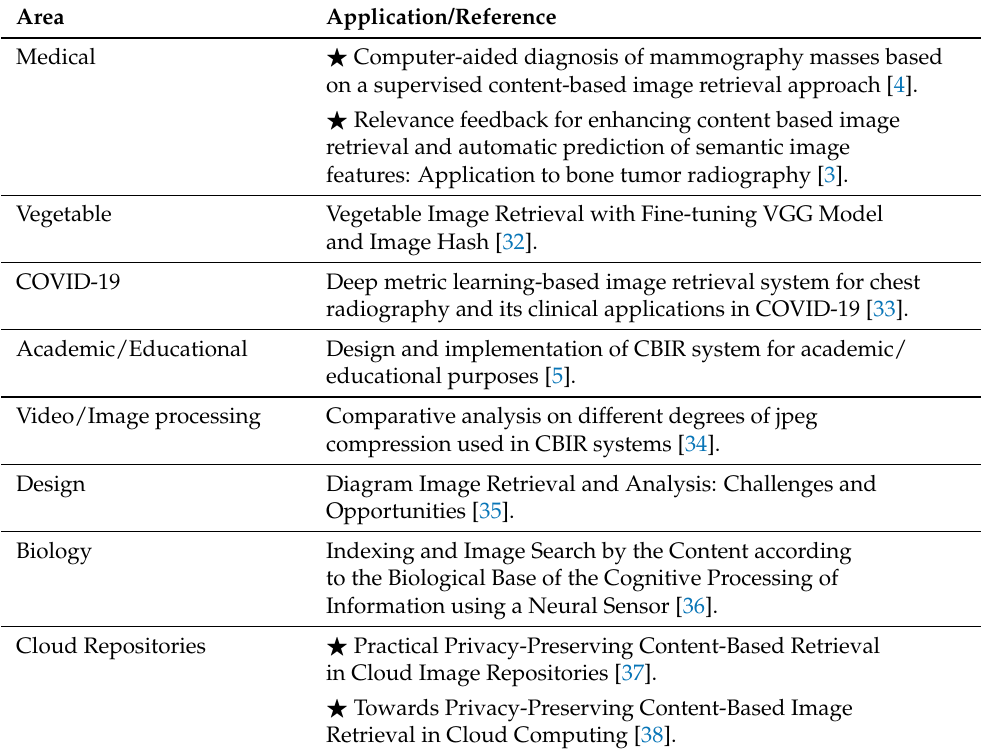
Table 1. Examples of some CBIR application